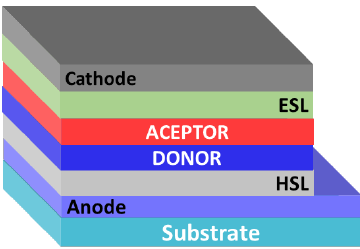
Figure 2. Architecture of organic solar cells with a planar p-n heterojunction.